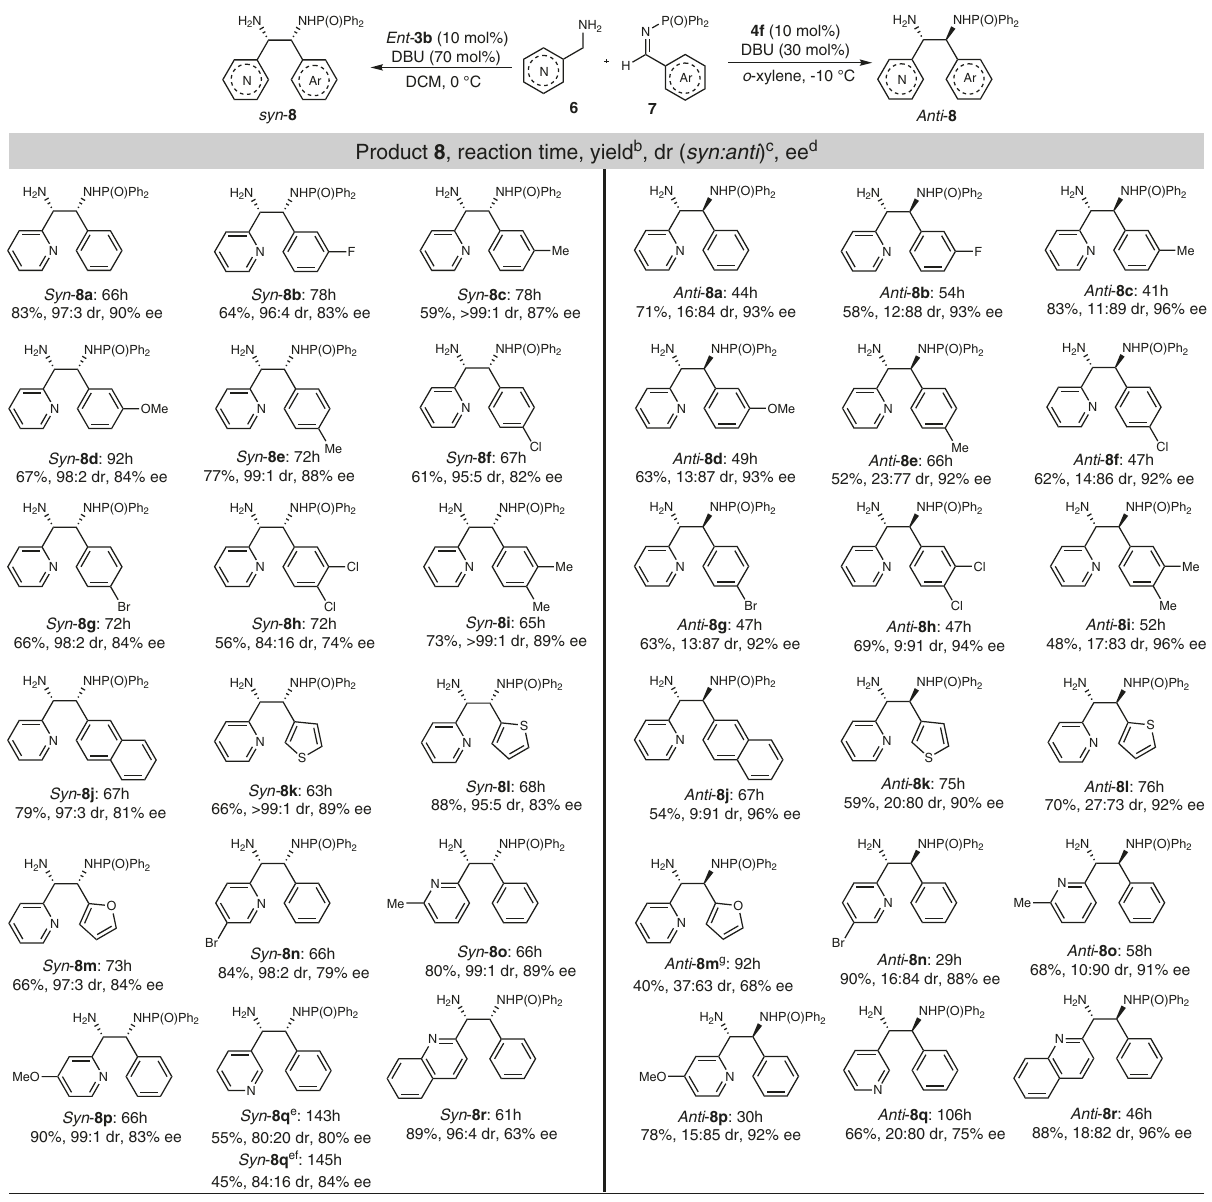
Fig. 3 Substrate scope of the Mannich reaction a . a Reaction conditions: 6 (0.1 mmol), 7 (0.13 mmol), ent - 3b or 4f (0.01 mmol), DBU (0.07 or 0.03 mmol), CH 2 Cl 2 (0.5 mL) or o -xylene (1.0 mL), at 0 o C or − 10 o C. b Isolated yield. c Determined by 1 H NMR. d Ee of the major diastereoisomer determined by chiral HPLC. e Using toluene as solvent. f Using 3d as a catalyst. g At 0 o